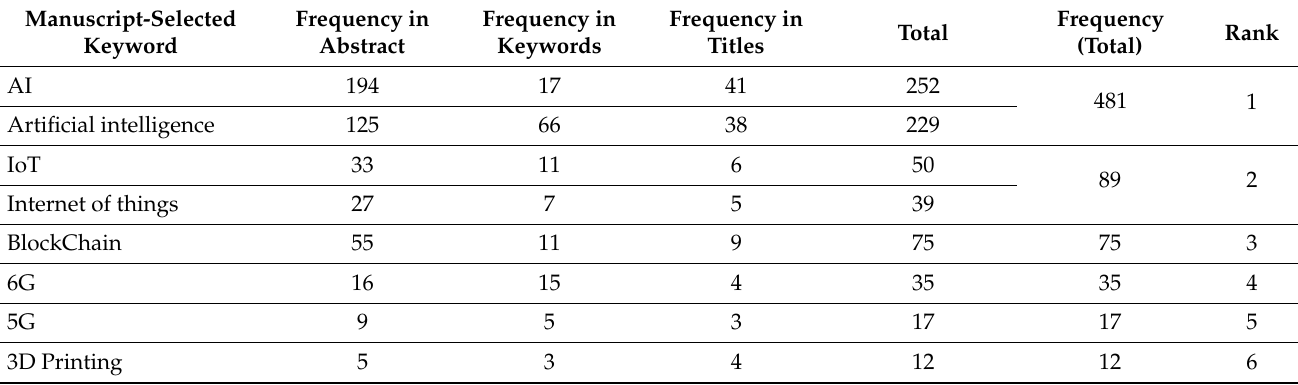
Figure 2. Sentiment analysis applied to titles and abstracts. Table 1. Text mining of the frequency of appearance of the most common disruptive technologies from this article’s database (n =